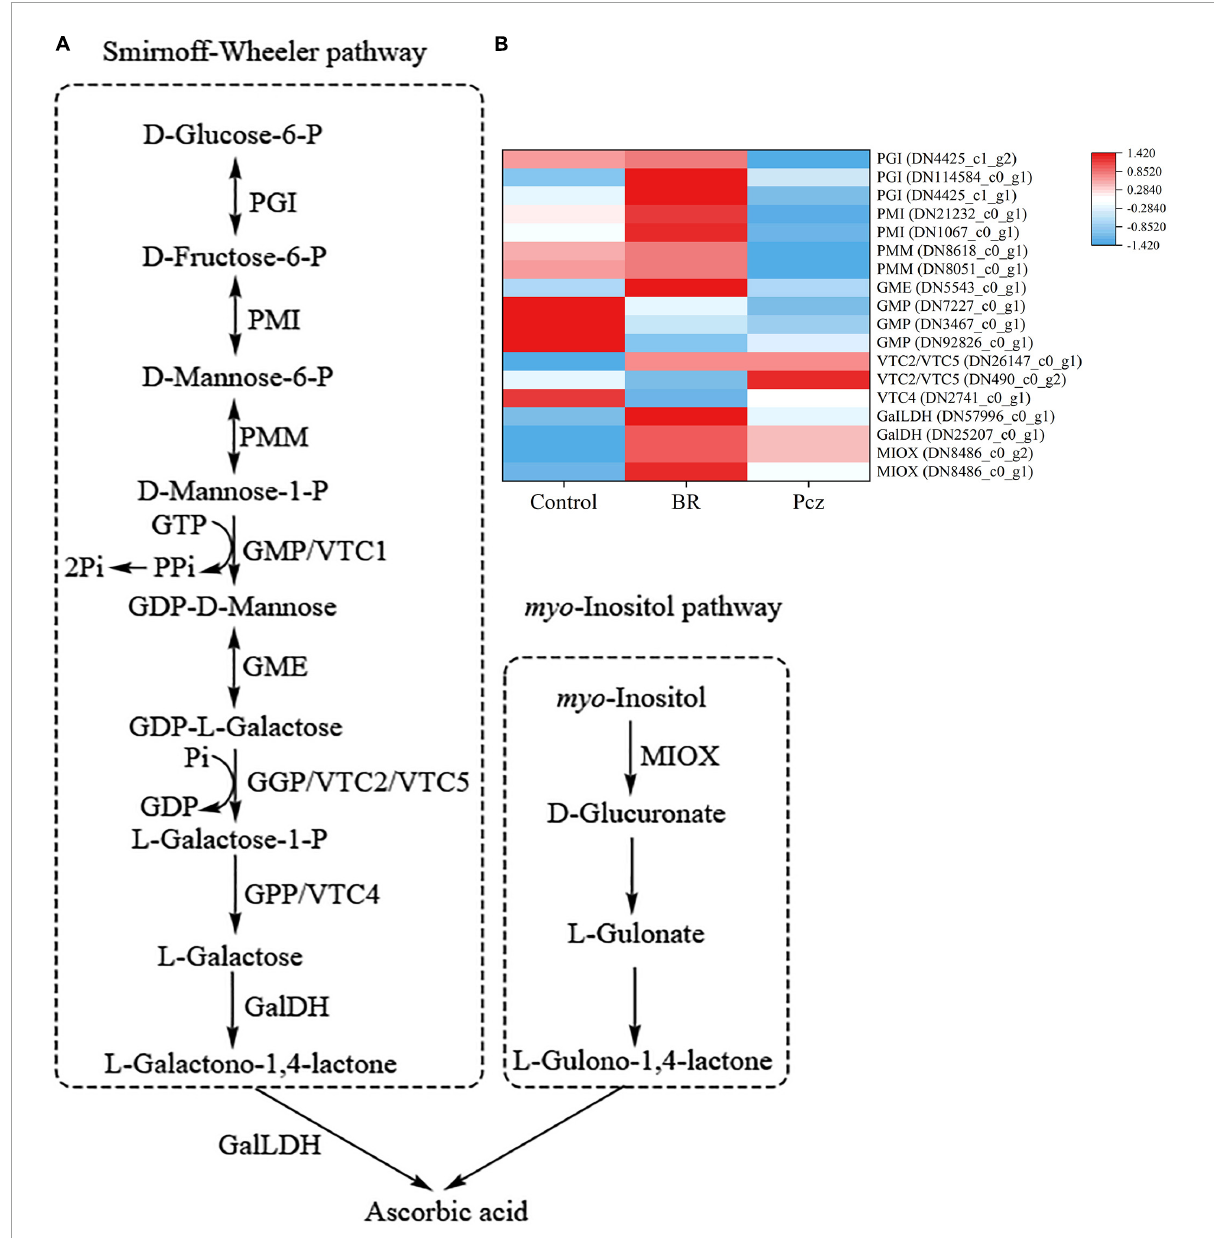
FIGURE8 Analysis of differentially expressed levels related to the ascorbic acid pathway in bulbil of P. ternata under BR and Pcz treatments. (A) , the ascorbic acid biosynthetic pathway. (B) , the expression levels of genes related to the ascorbic acid biosynthetic pathway. Blue indicates a lower expression level, whereas red indicates a higher expression level. All the data showed the average mean of three biological